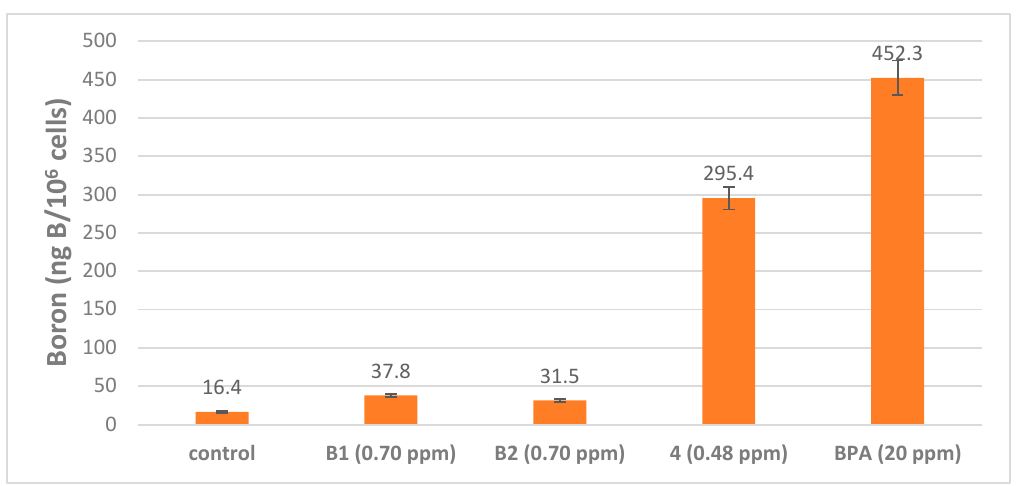
Figure 11. Boron concentrations in U87 cells.